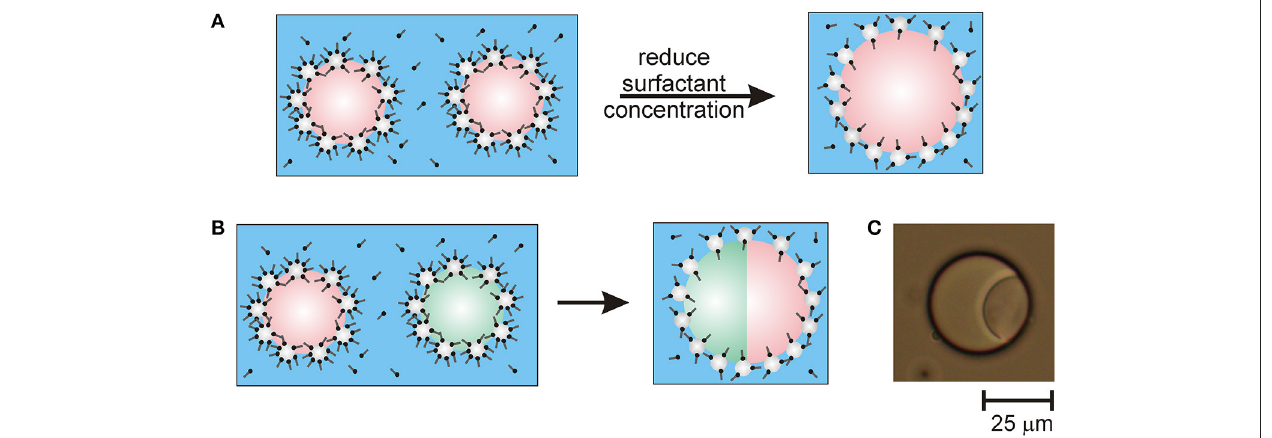
FIGURE 1 | Schematics of Pickering emulsion destabilization caused by reducing the surfactant concentration in emulsions stabilized by mixtures of particles and surfactant. (A) Destabilizing an emulsion containing drops of a single type of oil in water causes the drops to undergo limited coalescence. (B) Destabilizing an emulsion containing drops of two different immiscible types of oil causes the drops to fuse with multiple together into drops compartments. (C) Optical microscope image of a fused droplet containing compartments of olive oil and silicone oil.